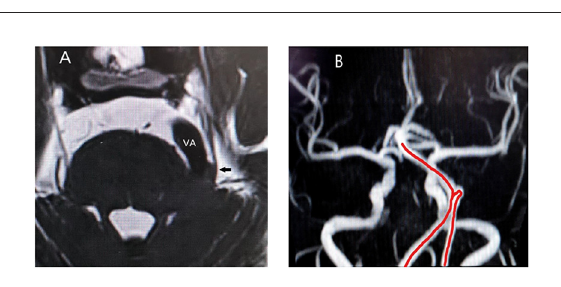
FIGURE3 (A) Relationship between trigeminal nerve and responsible vessel in a patient on sequences-3D-SPACE; VA, vertebral artery; arrow, trigeminal nerve; (B) The red line is the abnormal routing of vertebral artery on magnetic resonance